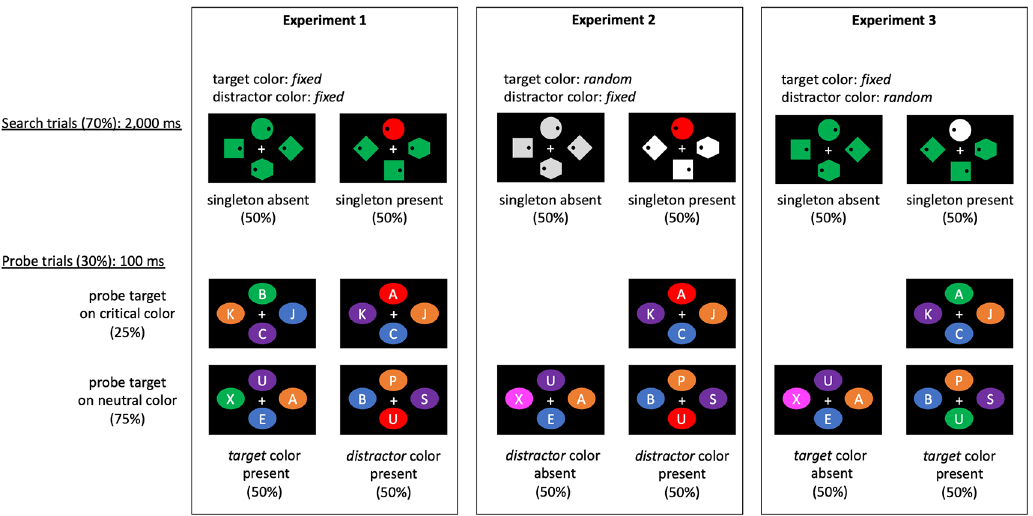
Figure 1. Schematic illustration of experimental trials. The search (70% of trials) and probe trials (30% of trials) were presented to the participants randomly. In the search trials (top panel), participants were asked to report whether a dot inside the search target (diamond) was presented on the left or right. The four stimuli had the same colorinhalfofthetrials(singletonabsent),whereasoneofthefourstimulihadadifferentcolor(singletonpresent)in the other half of the trials. The singleton was never the search target; thus, it functioned as a distractor. The color of the target stimulus was fixed (Experiments 1 and 3) or random (Experiment 2); the color of the distractor (singleton) was also fixed (Experiments 1 and 2) or random (Experiment 3). Notably, the task was just to identify the location of a dot inside the target (diamond), and the assigned color was irrelevant to the task. We examined whether or not the singleton-presence benefit can be obtained even when the target or distractor color was changed on a trial-by-trial basis.Intheprobetrials(bottompanel),thetaskwastodetectaprobetargetletter(AorB).InExperiment1,inhalfof the trials, the target color (e.g., green) in the visual search was presented, while in the other half, the distractor color (e.g., red: a singleton color in the visual search) was presented. The probe target letter appeared in a critical color (either of the target or distractor color in search trials) or in a neutral color (a color that had not been presented in search trials). The probe presentation in the target or distractor feature that was presented in the search trials enabled the assessment of the target enhancement and distractor suppression separately. In Experiments 2 and